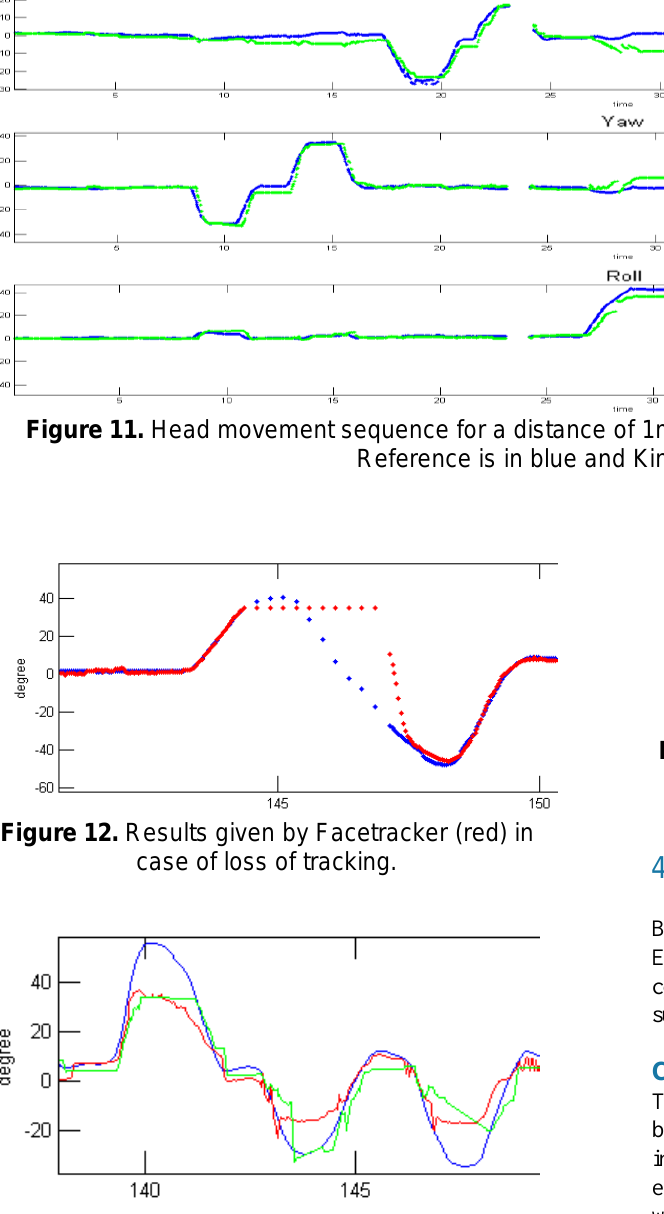
Figure 13. Errors are observed with some angular movement due to loss of tracking. The reference is blue, KinectSDK is green and Facetracker is red.